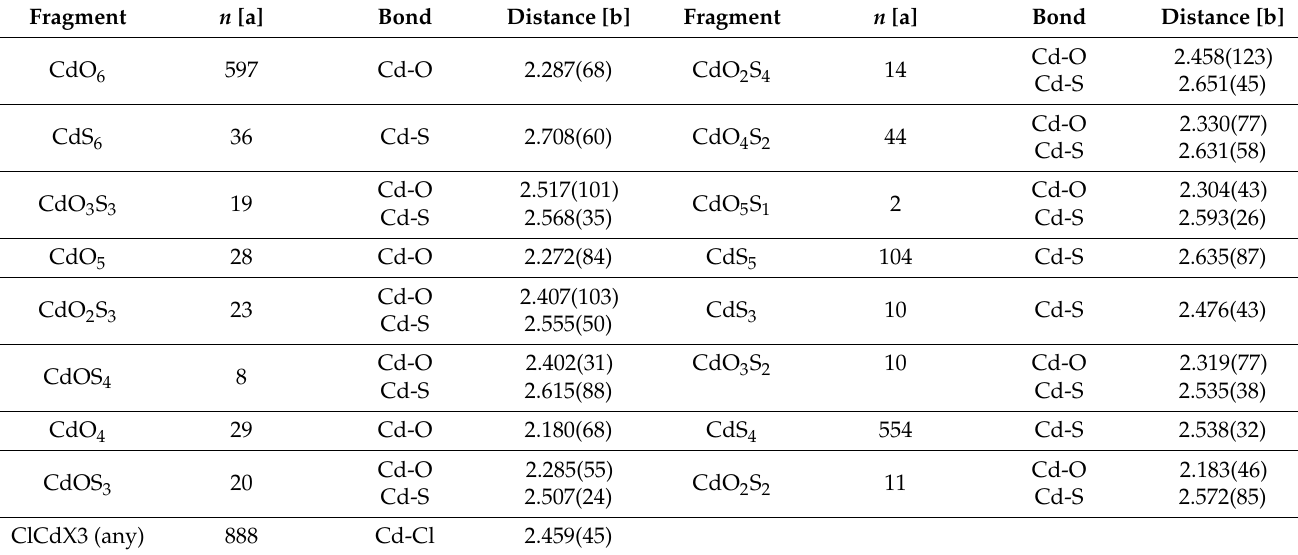
Table 3. Average of bond lengths and angles for relevant structures surveyed from the Cambridge Structural